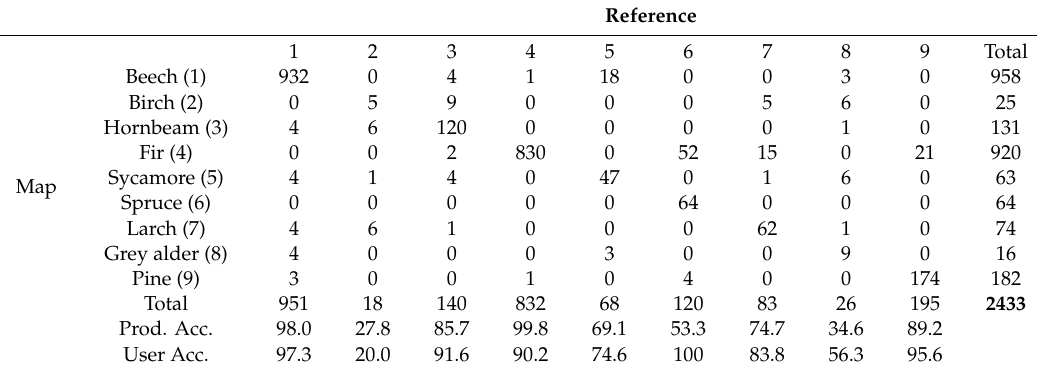
Confusion matrix for the best classification of five images (30-April / 05-May / 14-October / 17-October /